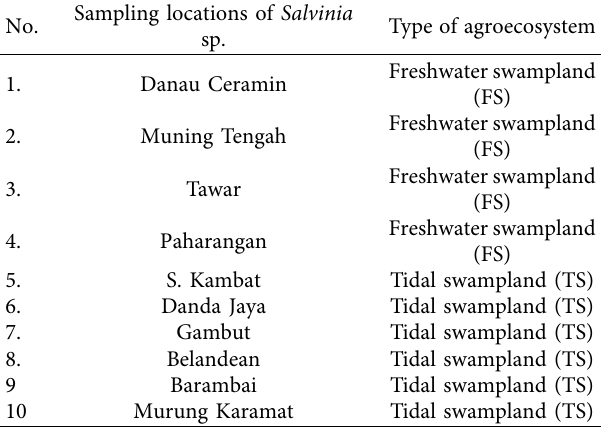
Table 1: Sampling locations and type of agroecosystem of 10 accessions Salvinia sp. in South